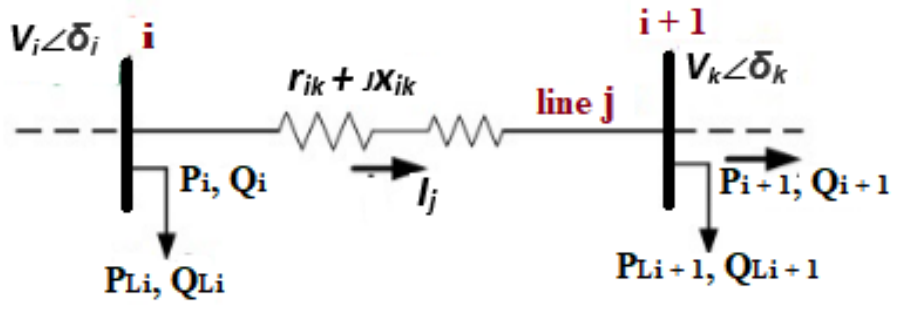
Figure 1. Two nodes distribution network